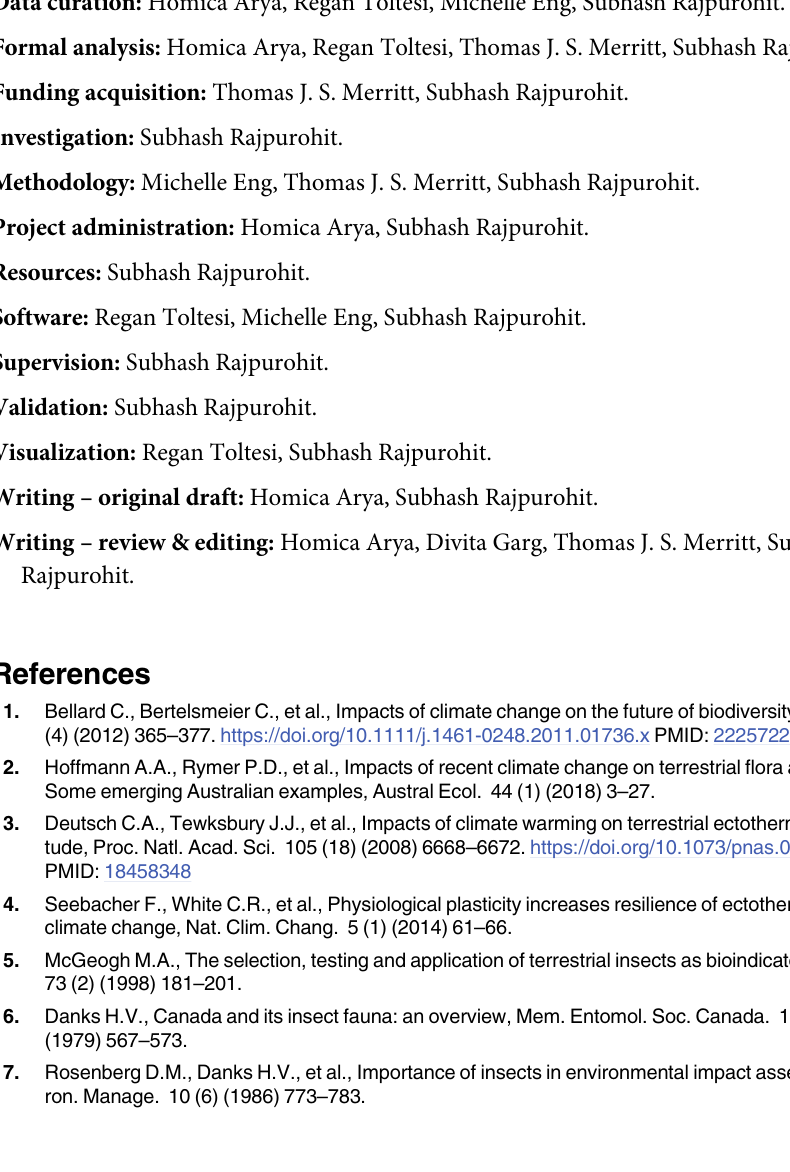
S1 Table. Metabolome compound hits data. S2 Table. Pathway enrichment analysis